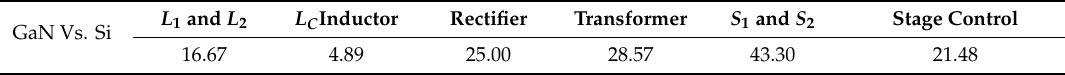
Table 9. Power reduction percentage; first vs. third array.